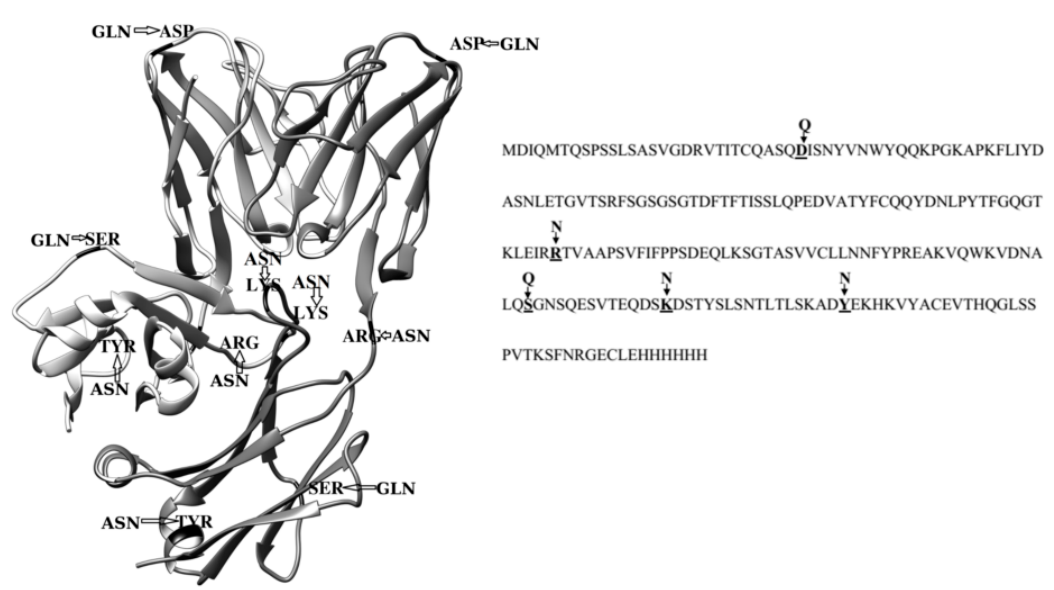
Figure 1. The scheme of locations of point mutations in amino acids sequence of BIF protein and in its C L and V L domains (the structure of immunoglobulin kappa light-chain dimer (Bence-Jones protein) DEL (PDB ID: 1B6D) was used as a model [10]). The picture was built using Chimera 1.13.1 (UCSF, San Francisco, CA, USA).